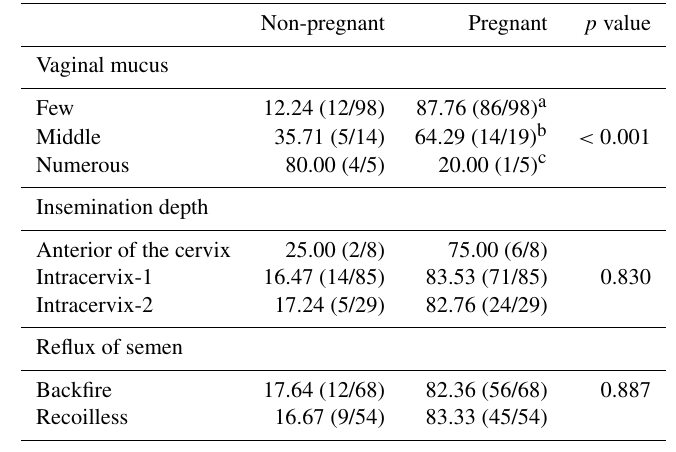
Table 3. Values of factors affecting insemination